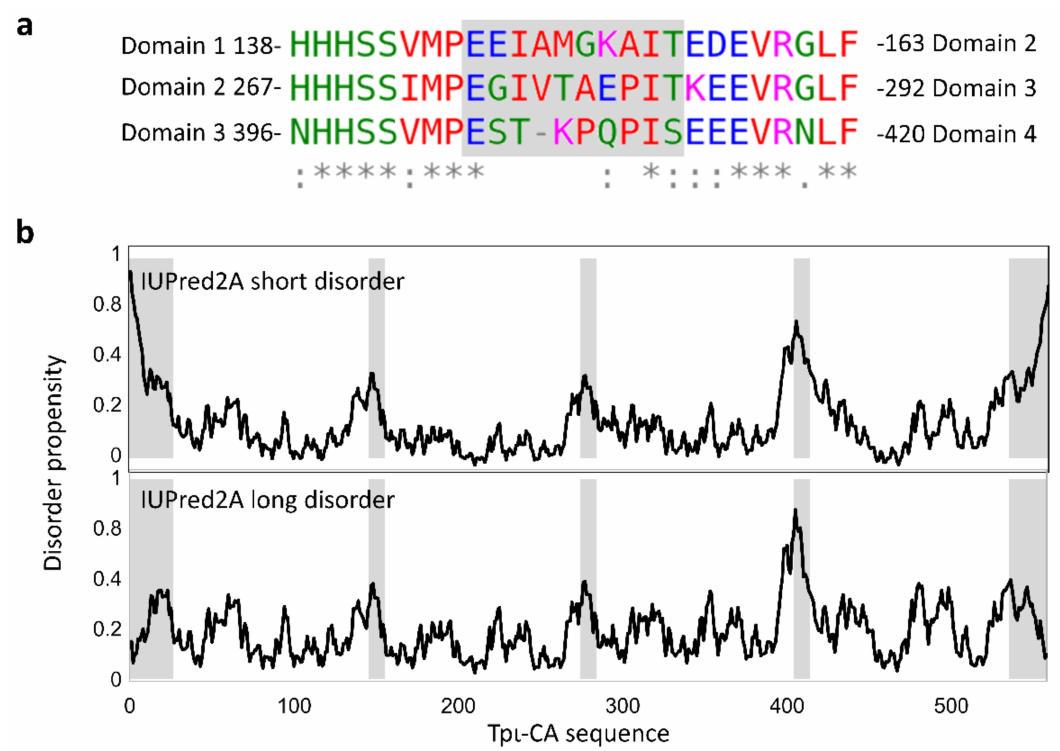
Figure 6. Flexibility of the interdomain linkers. ( a ) Clustal ω alignments of the linkers between domains 1 and 2, domains 2 and 3, and domains 3 and 4. The linker residues are shaded in grey. ( b ) IUPred2A disorder prediction for short disordered regions (top) or long disordered regions (bottom). Only the linker between domains 3 and 4 is predicted to be a long-disordered